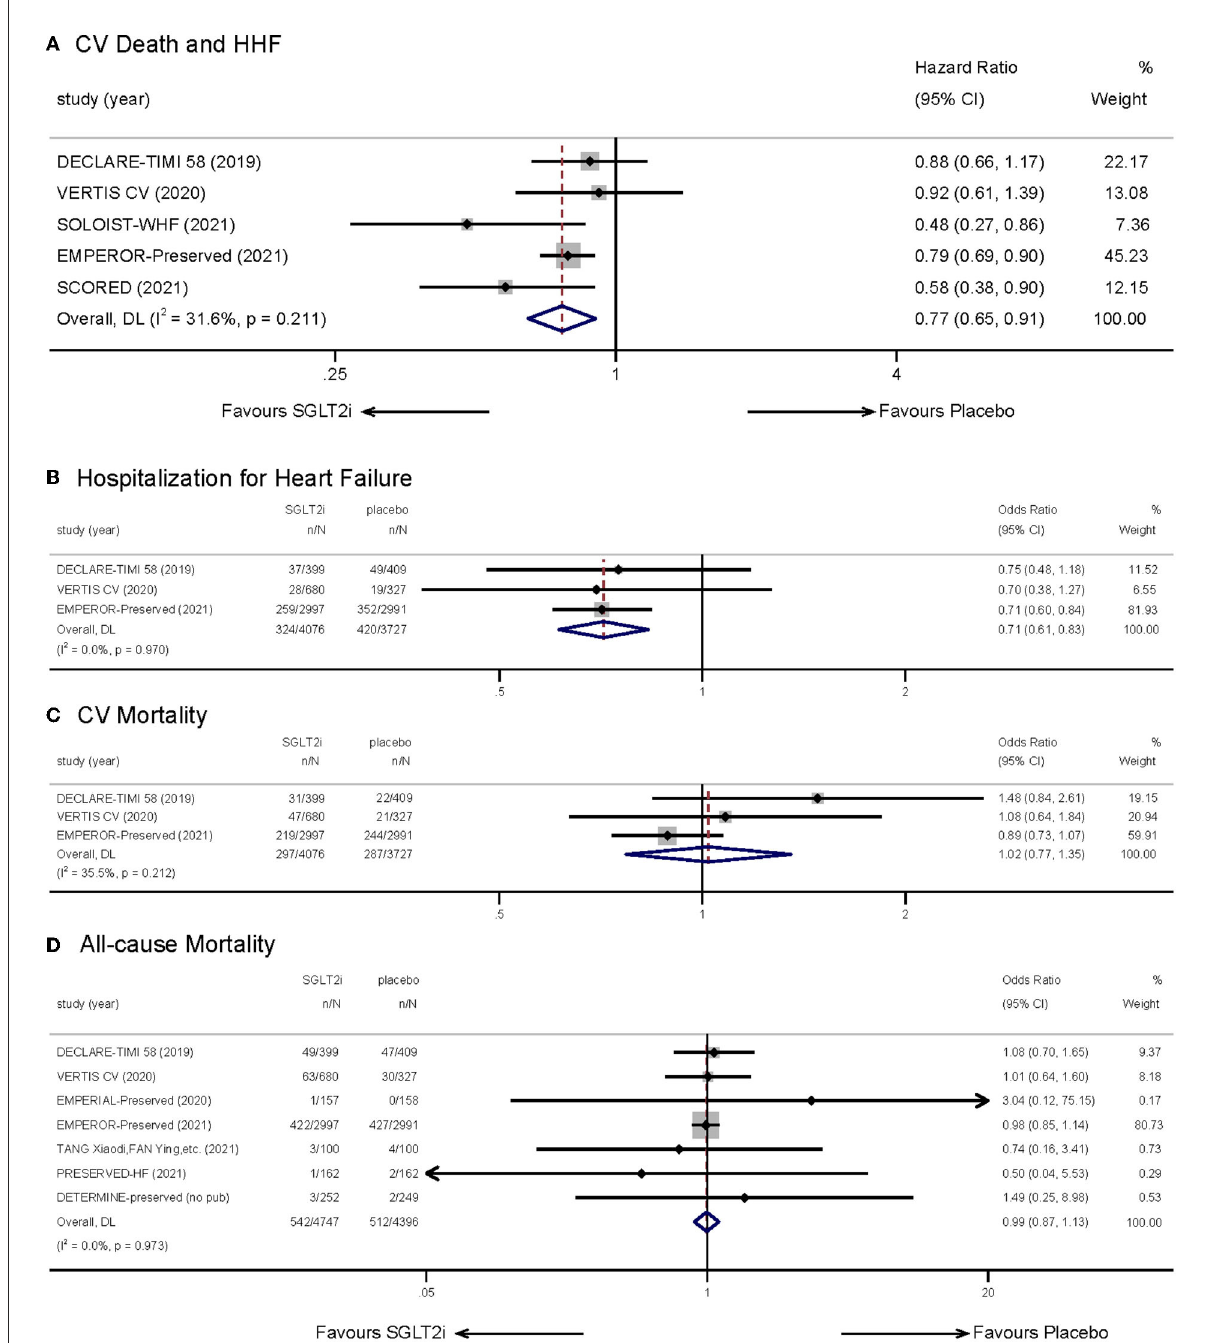
FIGURE3 Effect of SGLT-2 inhibitors vs. placebo on the primary outcome of (A) cardiovascular death and hospitalization for heart failure; (B) hospitalization for heart failure; (C) cardiovascular mortality; (D) all-cause mortality.